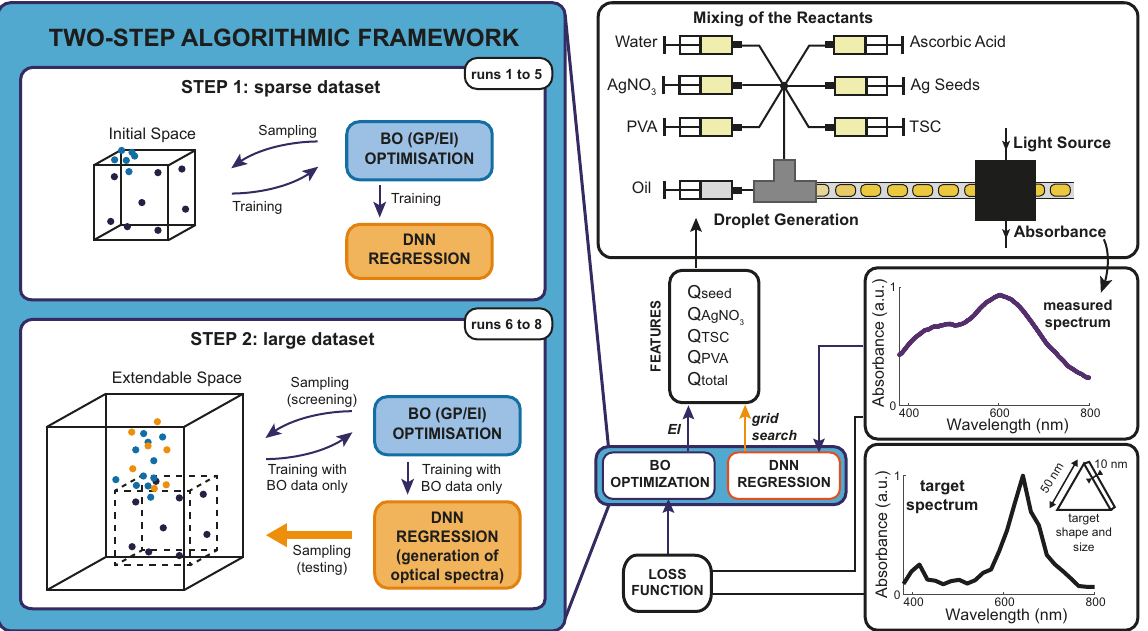
Fig. 1 Algorithmic framework for a high-throughput experimental loop. The two-step optimization algorithmic framework (blue box) consists of a fi rst HTE loop (runs 2 – 5) in which the BO (blue points) is sampling the parameter space to train a DNN and a second loop (runs 6 – 8) in which the DNN (orange points) is allowed to sample the parameter space to validate its regression function. The conditions suggested by the BO and the DNN are tested on a droplet-based micro fl uidic platform. The absorbance spectrum of each droplet is measured and compared to the target spectrum through the loss function before feeding the BO, while the fully resolved absorbance spectrum is provided to the